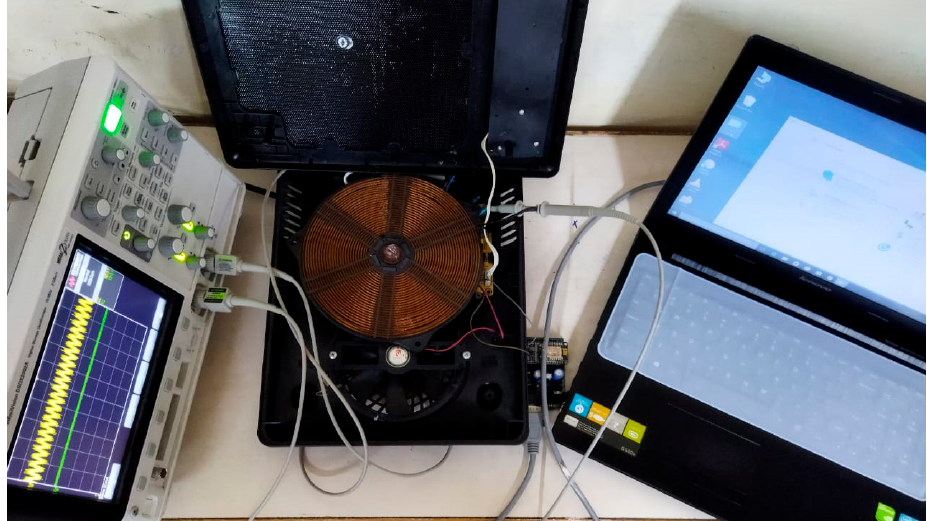
Figure 15. Experimental set-up of 2 kW induction heating system.